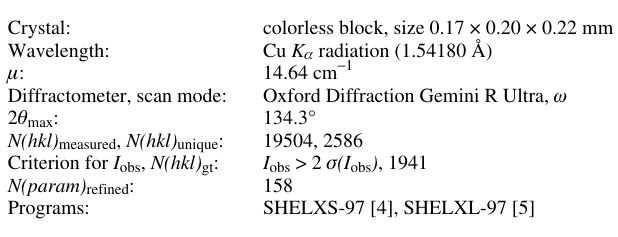
Table 1. Data collection and handling.